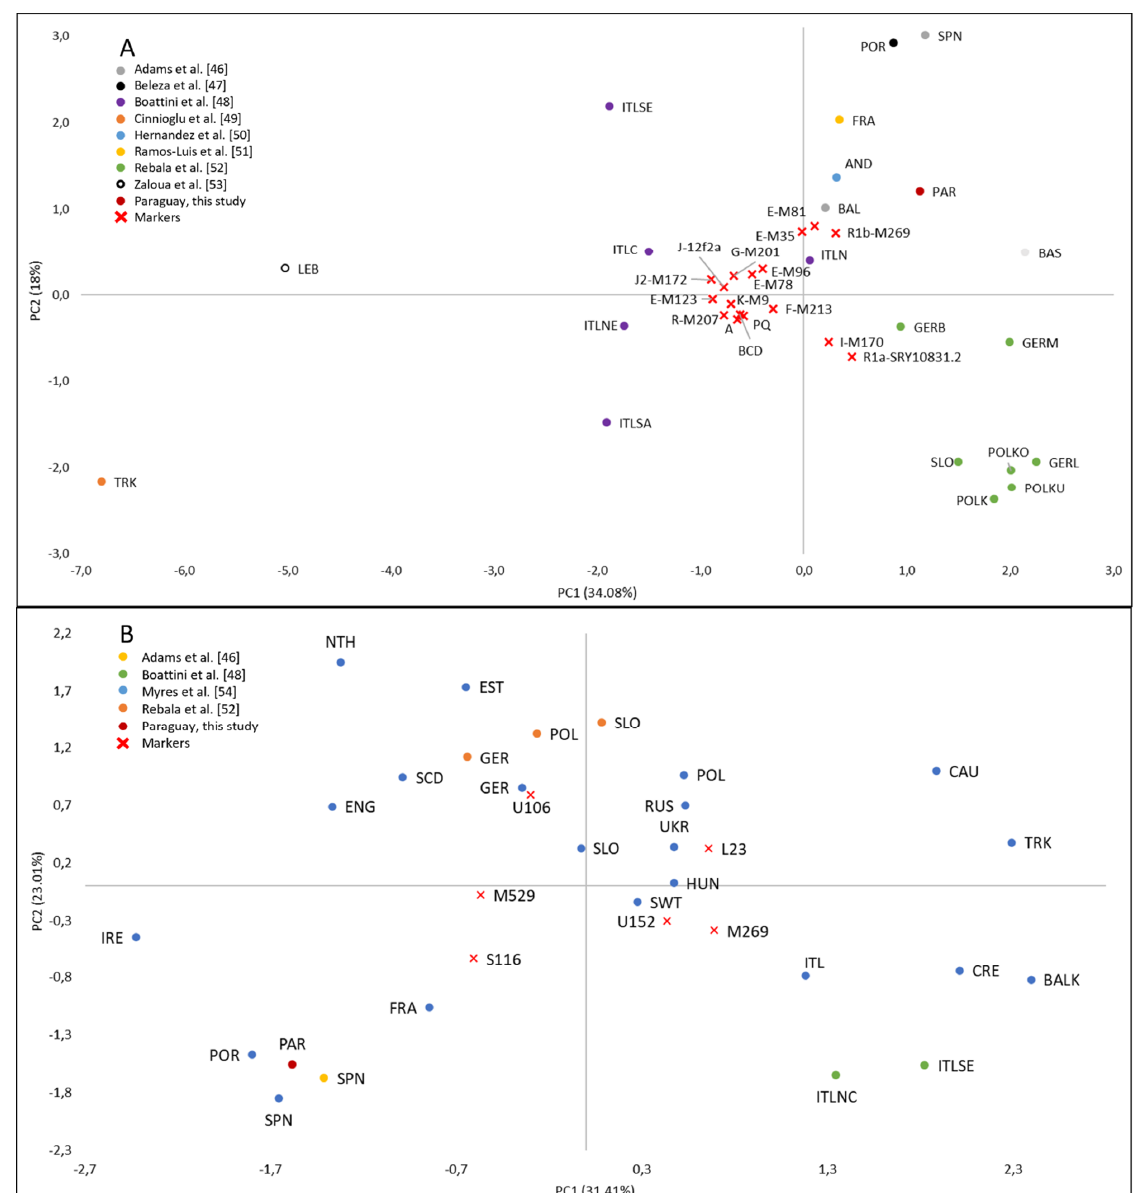
Figure 5. Principal component analysis of ( A ) European haplogroup frequencies in Paraguay and in European popula- tions; ( B ) R1b-L23, R1b-M269, R1b-U106, R1b-S116, R1b-U152 and R1b-M529 haplogroup frequencies in Paraguay and in